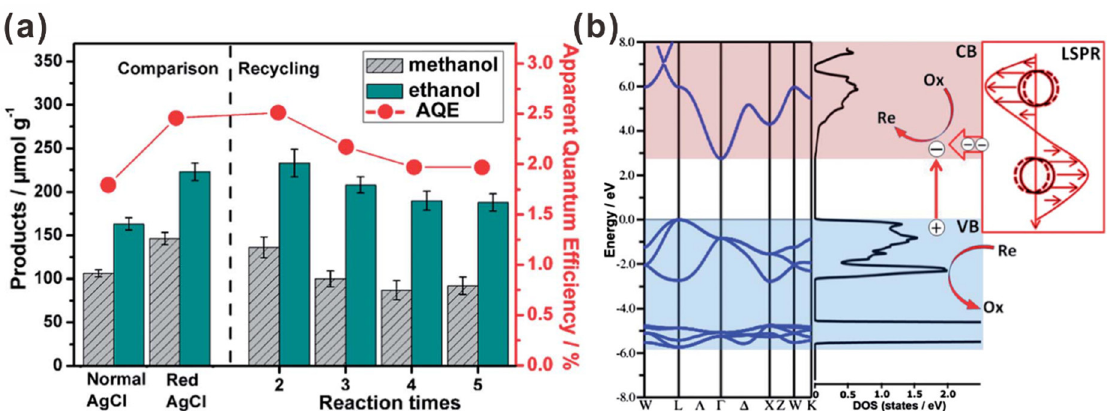
Figure 5. ( a ) The comparison of the photocatalytic efficiency for CO 2 reduction to CH 3 OH and C 2 H 5 OH with red Ag/AgCl, and ( b ) a schematic illustration of physical photocatalytic mechanism. Reproduced with permission from Reference [82]. Copyright 2014 Royal Society of Chemistry.